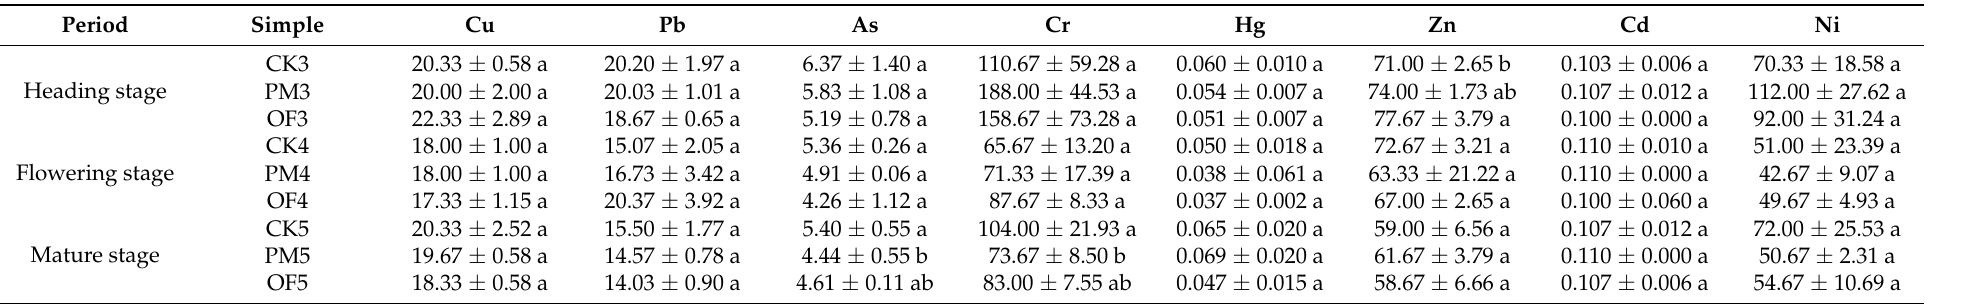
Table 1. Effects of manure application on heavy metals in paddy soil (mg · kg − 1